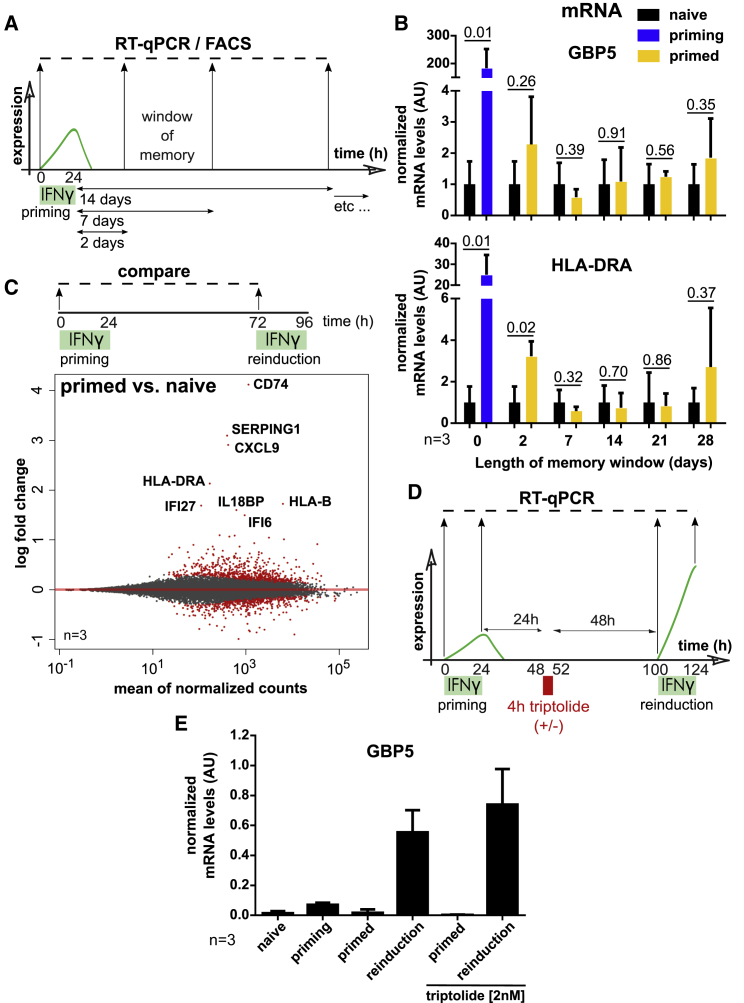
GBP5 and HLA-DRA mRNA Levels in Primed Cells Return to the Pre-induced Levels of Naive Cells, and Ongoing Transcription Is Not Required for Maintenance of Transcriptional Memory(A) Scheme to measure long-term transcriptional output of memory genes following priming.(B) HeLa cells were subjected to the IFNγ treatment regimen outlined in (A) and processed for RT-qPCR of GBP5 and HLA-DRA mRNA. Signals were normalized to ACTB expression and internally to naive cells. Error bars, SD; n = 3 biological replicates; numbers represent the p values.(C) Representation of processed RNA-seq data in HeLa cells analogous to data in Figure 1C but for primed over naive cells.(D) Outline of the triptolide-based RNA Pol II inhibition experiment.(E) HeLa cells were subjected to the IFNγ and triptolide treatment regimen outlined in (D) and processed for RT-qPCR of GBP5 mRNA. Signals were normalized to ACTB expression. Error bars, SD; n = 3 biological replicates.See also Figure S3.